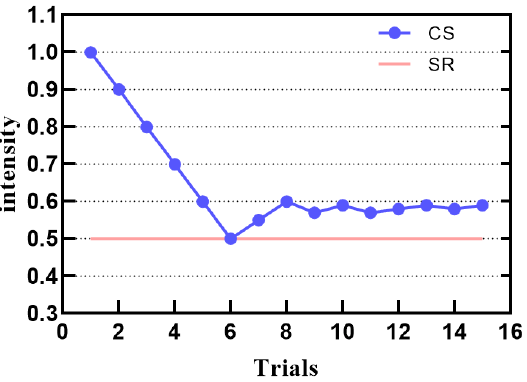
Figure 9. Psychophysical adaptive staircase for subject 2 with a reference flow rate of 0.5.